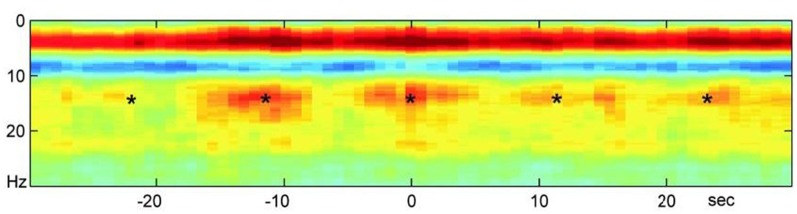
A neocortical power spectrogram and slow oscillatory entrainment. A power spectrogram used to represent neural oscillatory activity maps visually the power of varying frequencies on the spectrum of neural oscillations over time. The spectrogram shown here reveals the normalized average of power spectrograms of a large set of mice. The activity consists of hippocampal ripples over the neocortex during sleep. This spectrogram demonstrates the hierarchical nature of spectral entrainment and superimposition in which slower oscillations modulate the higher ones as well as the propensity for the slow oscillations to synchronize higher frequency activity in different neural areas. The *s represent hippocampal ripples that reveal co-modulation and entrainment of the neocortex and hippocampus by the infra-slow rhythm (0.1 Hz). In addition, this ripple activity is modulated by the Beta activity and both are modulated by the Delta Activity shown in the solid red band indicating its power during sleep. All three layers above the first are in turn biased by the infra-slow rhythm. Clearly, entrainment by slower oscillations exists at multiple levels. Image reproduced from Sirota et al. (2003); permission provided by CC-BY, Copyright 2003 National Academy of Sciences.